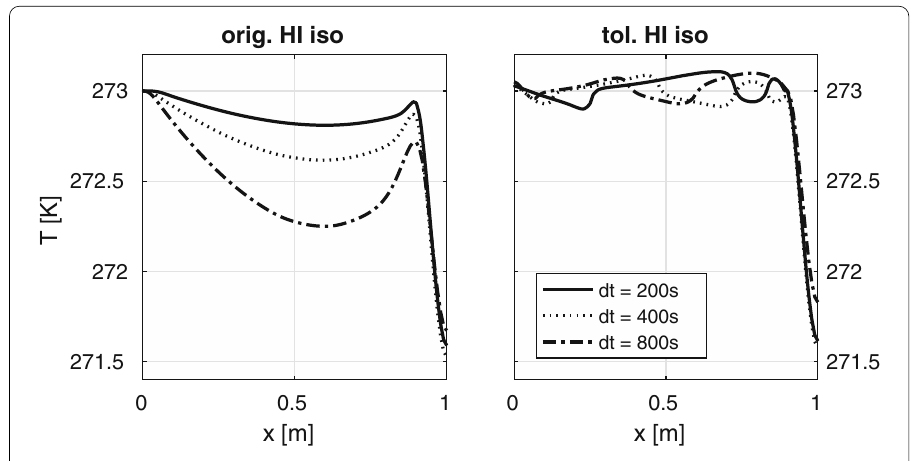
Fig. 10 Melting volume example: temperature profiles at 0 . 5 t f obtained from the original and the proposed tolerance-based HI scheme (100 elements, time step